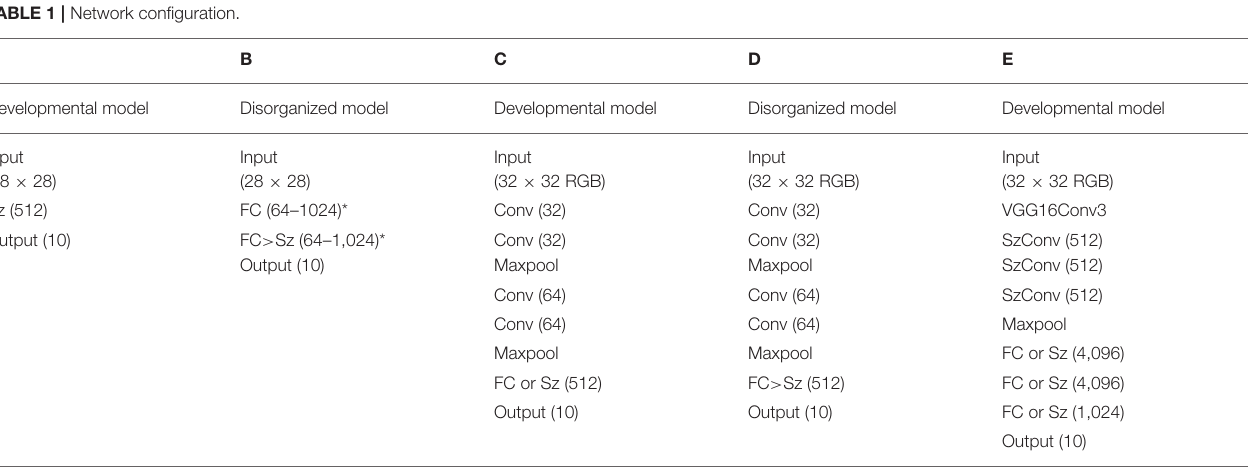
TABLE 1 | Network